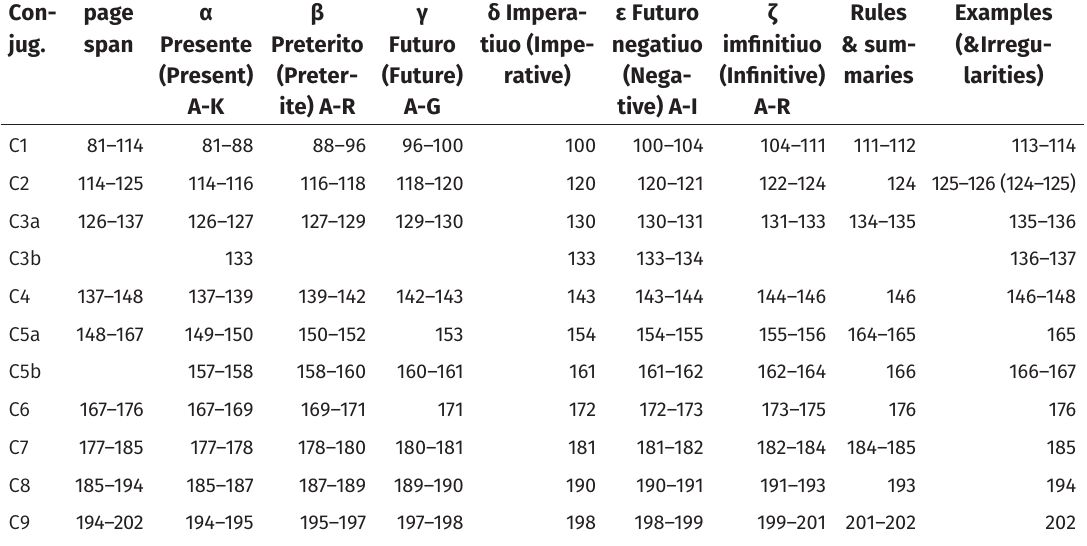
Table 1: Distribution of 759 items, and additional information, inside the largest section for the verbal paradigm in Hein & Rajam (2013: